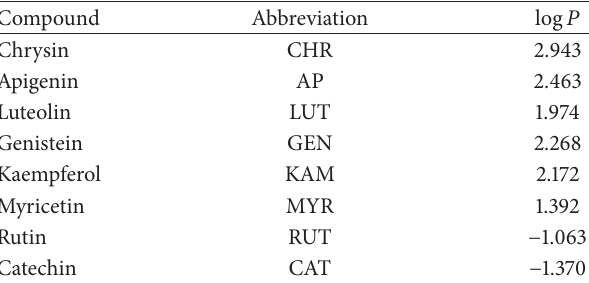
Table 1: Polarity of studied